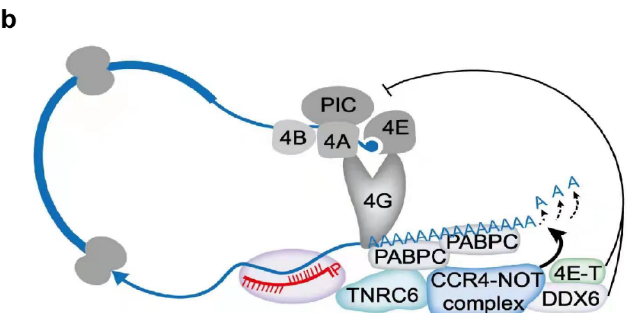
Figure 1. Canonical miRNA processing and relevant mechanism of silencing complex. ( a ) Located in the nucleus, miRNA precursors with cap-ring and hairpin structures are transcribed by the action of RNA polymerase II, transported into the cytoplasm, and loaded into AGO proteins to form silencing complexes, before exerting their biological roles. ( b ) The silencing complex recruits a number of complex proteins, including TNRC6, CCR4–NOT, and DDX6. The silencing complex binds the 3 (cid:48) -UTR of mRNA, thereby accelerating mRNA degradation and inhibiting translation